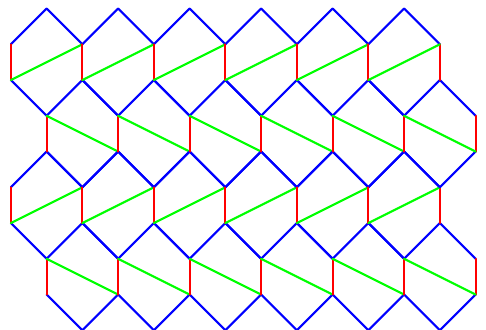
Fig. 33: Tiling with square, rectangle and two